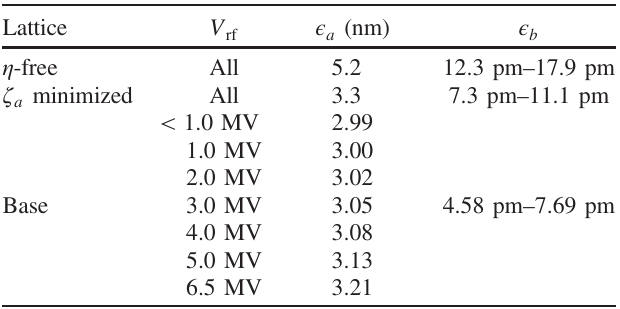
TABLE II. Simulation parameters: zero current emittances. The presence of ζ a in the “ Base ” lattice creates a rf voltage dependent zero current a -mode